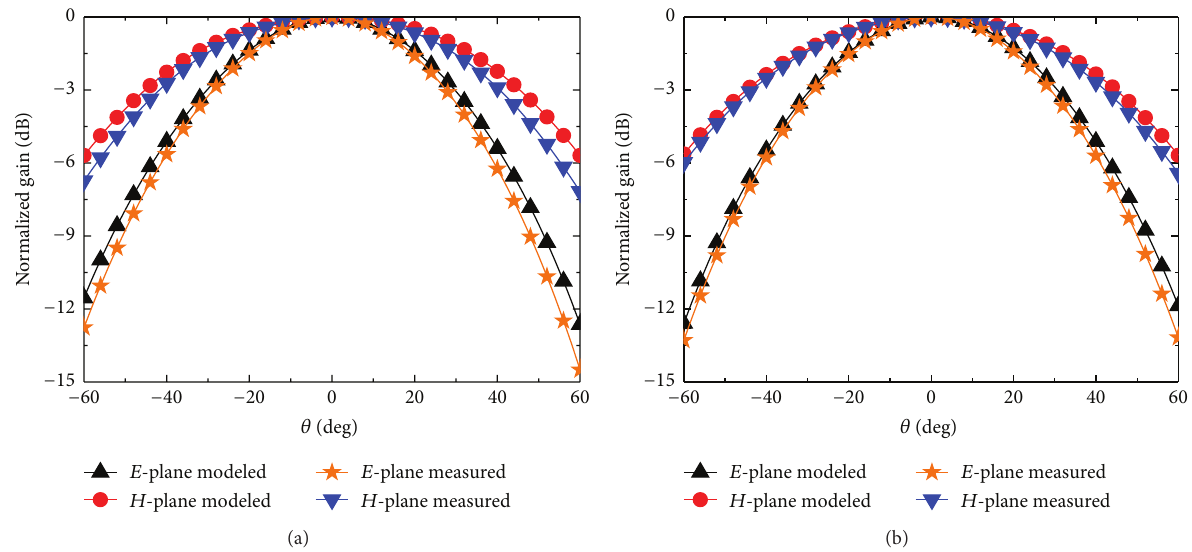
Figure 10: Normalized radiation patterns of the proposed antenna. (a) Radiation pattern with port 1 excited. (b) Radiation pattern with port 2 excited.